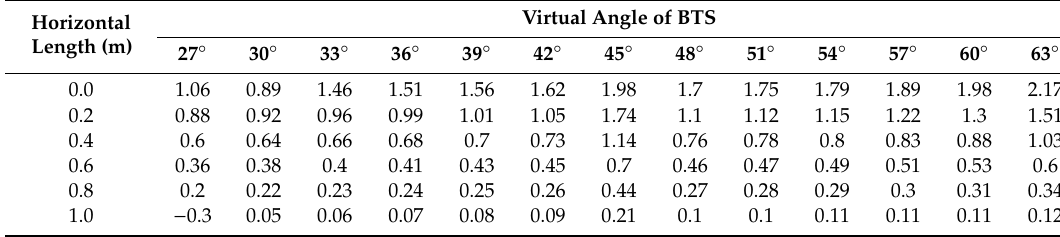
Table 1. Final results concerning weights at di ff erent wind